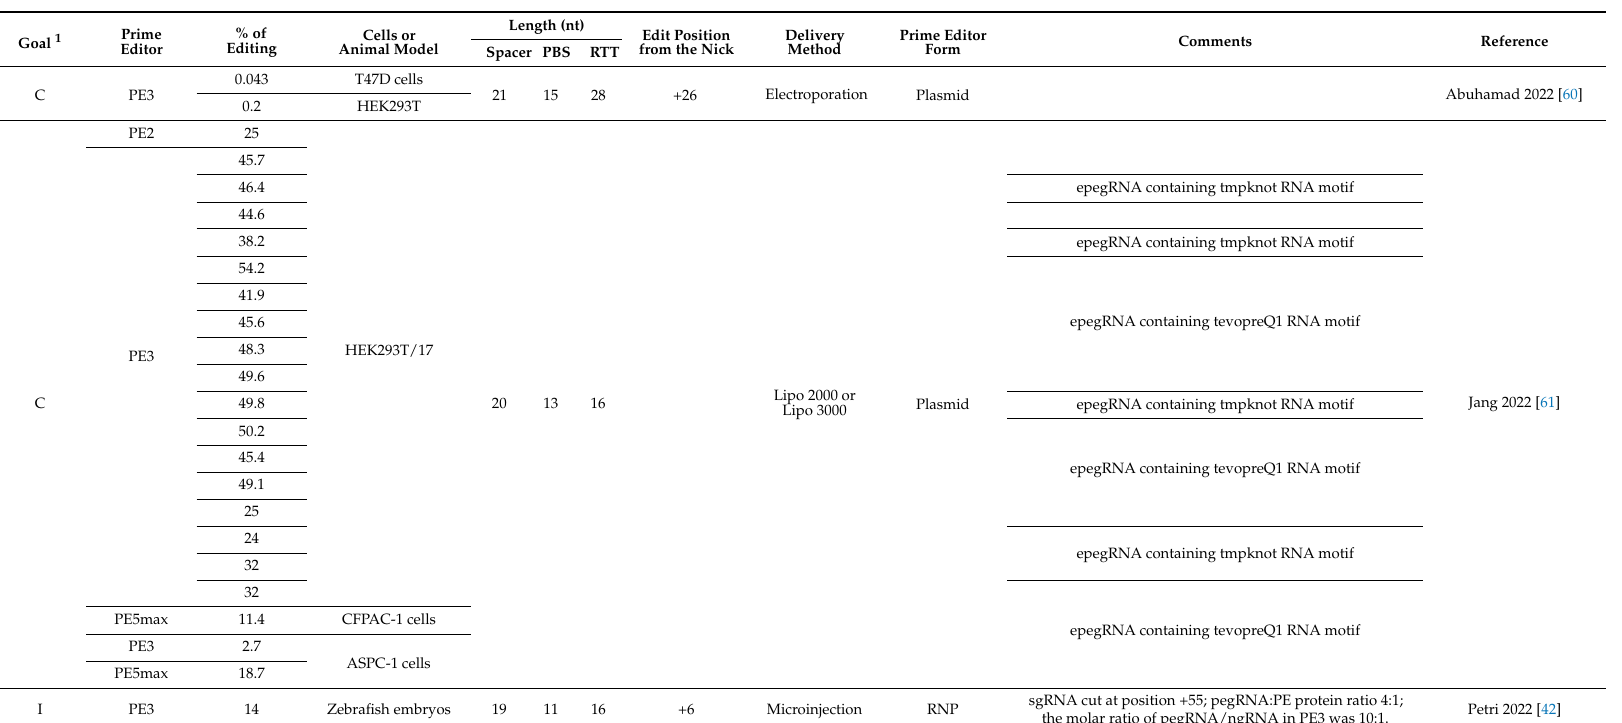
Table 7. Prime editing studies on correcting or introducing genetic mutations predisposing to